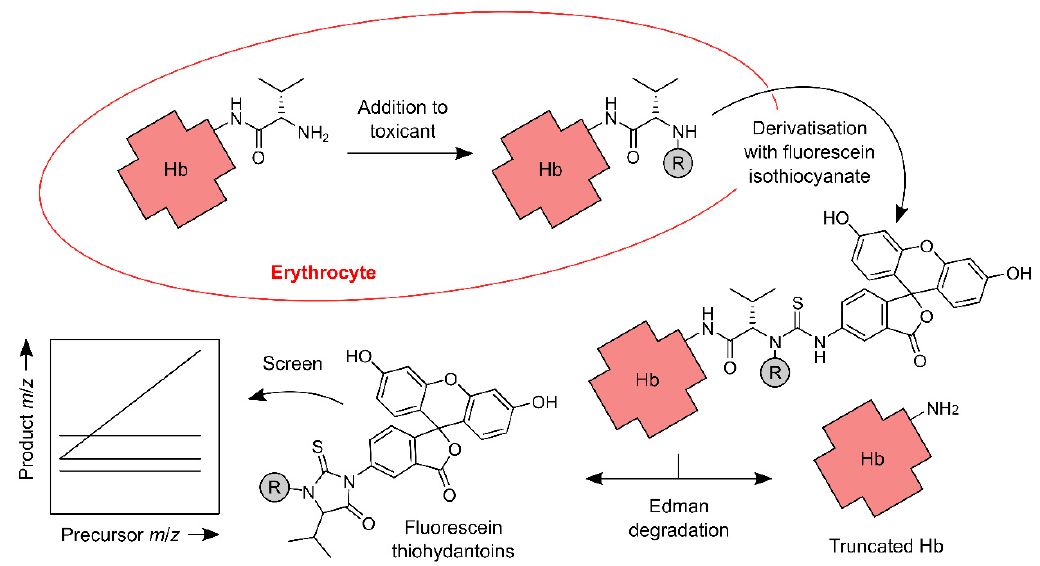
Figure 1. Main steps of the FI R E (‘fluorescein isothiocyanate’, ‘ R -group’ and ‘Edman degradation’) screening procedure for Hb N -terminal adductomics. The procedure detects ‘R’ groups, which are generated when an N -terminus of Hb reacts with an electrophile in vivo. The N -termini are derivatised with fluorescein isothiocyanate, and derivatives with ‘R’ groups are selectively decomposed to the corresponding fluorescein thiohydantoins. The thiohydantoins are analysed using LC and online ‘stepped’ triple quadrupole mass spectrometry.